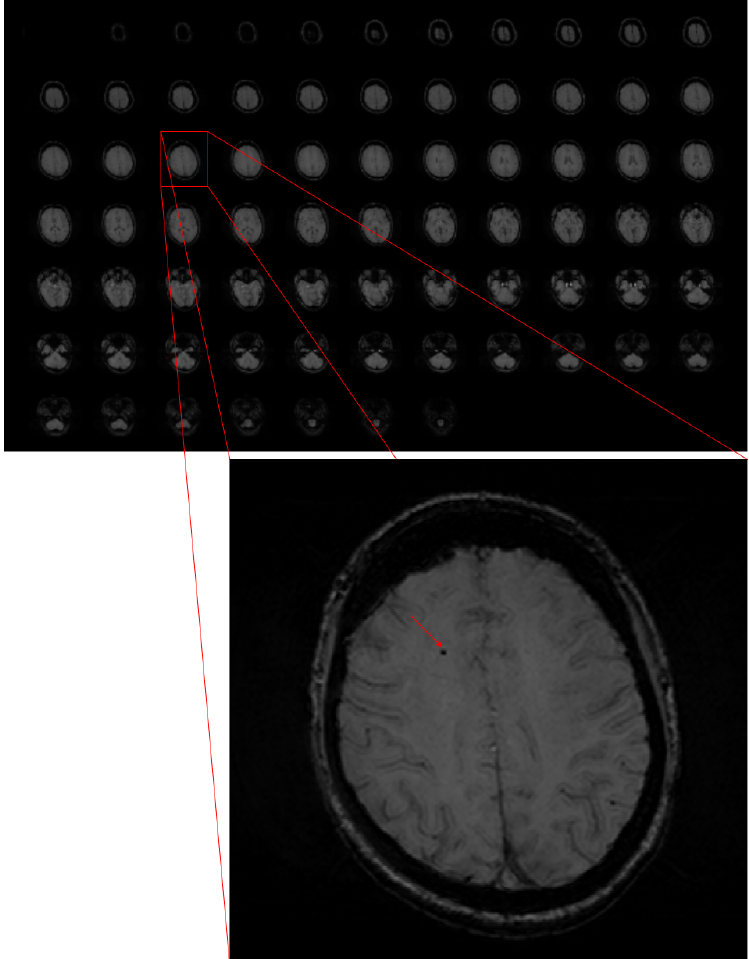
Figure 1. Sample of SWI sequence from MR image. One of the slices is enlarged to visualise a cerebral microbleed, marked with the red